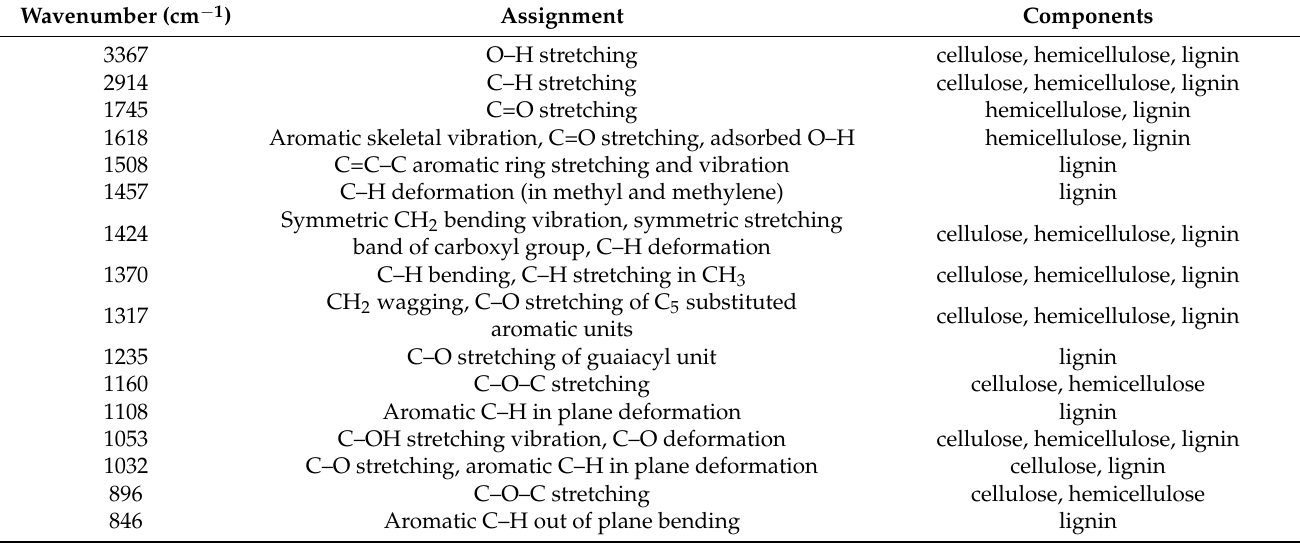
Table 2. FTIR band assignments of poplar and its major components: cellulose, hemicellulose, and lignin [19]. Wavenumber (cm − 1 ) Assignment